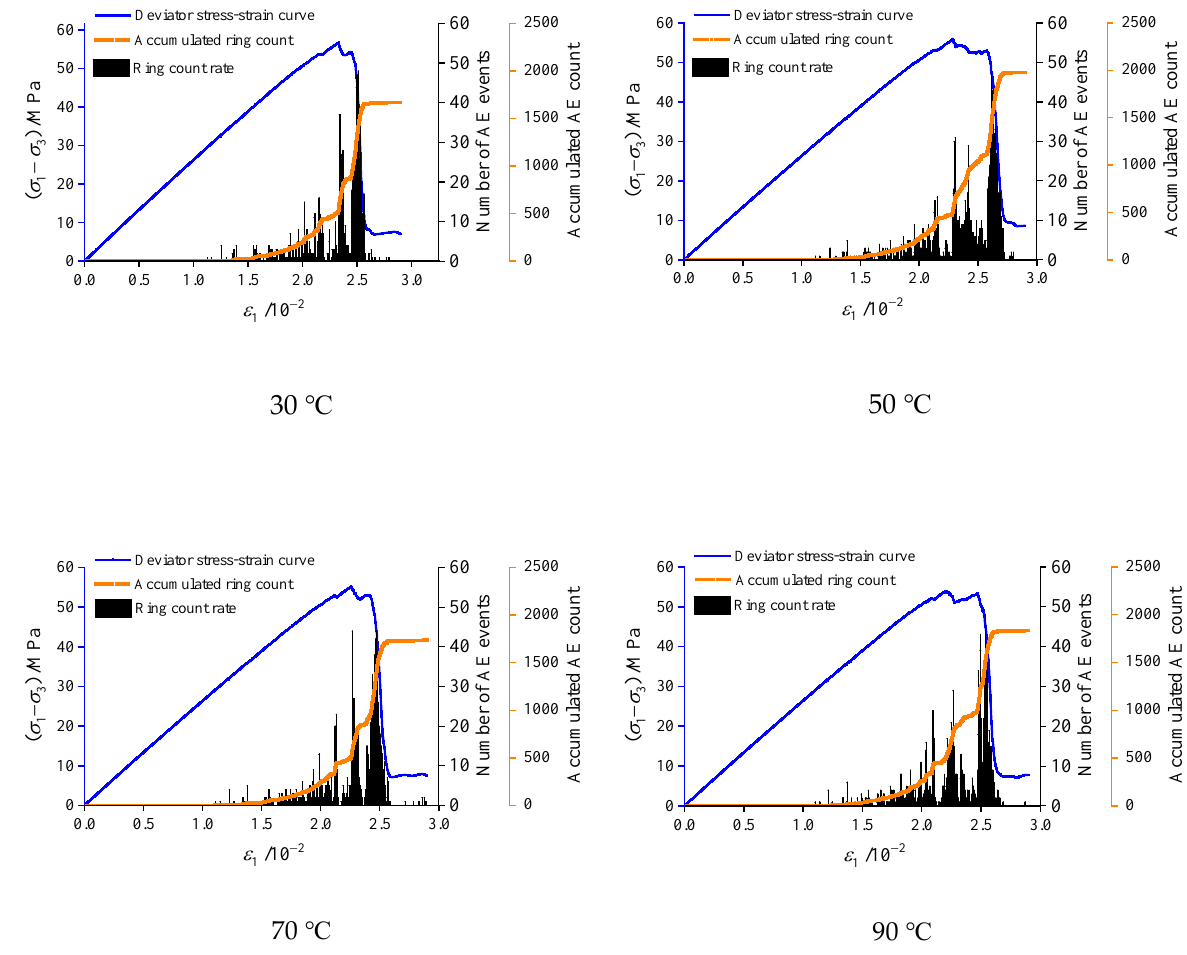
Figure 7. Deviatoric stress, number of AE events, and accumulated AE count versus axial strain.